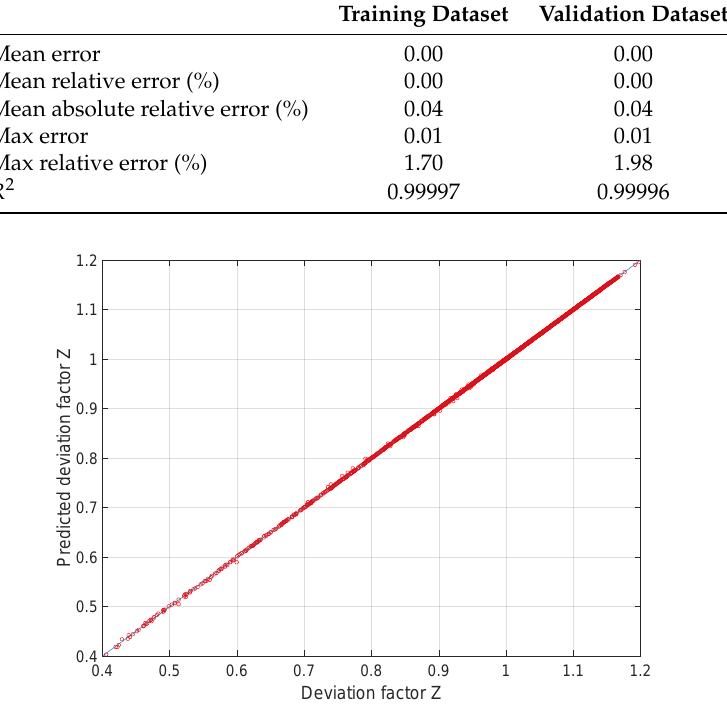
Figure 7. Performance of the TR-KRR model on the training